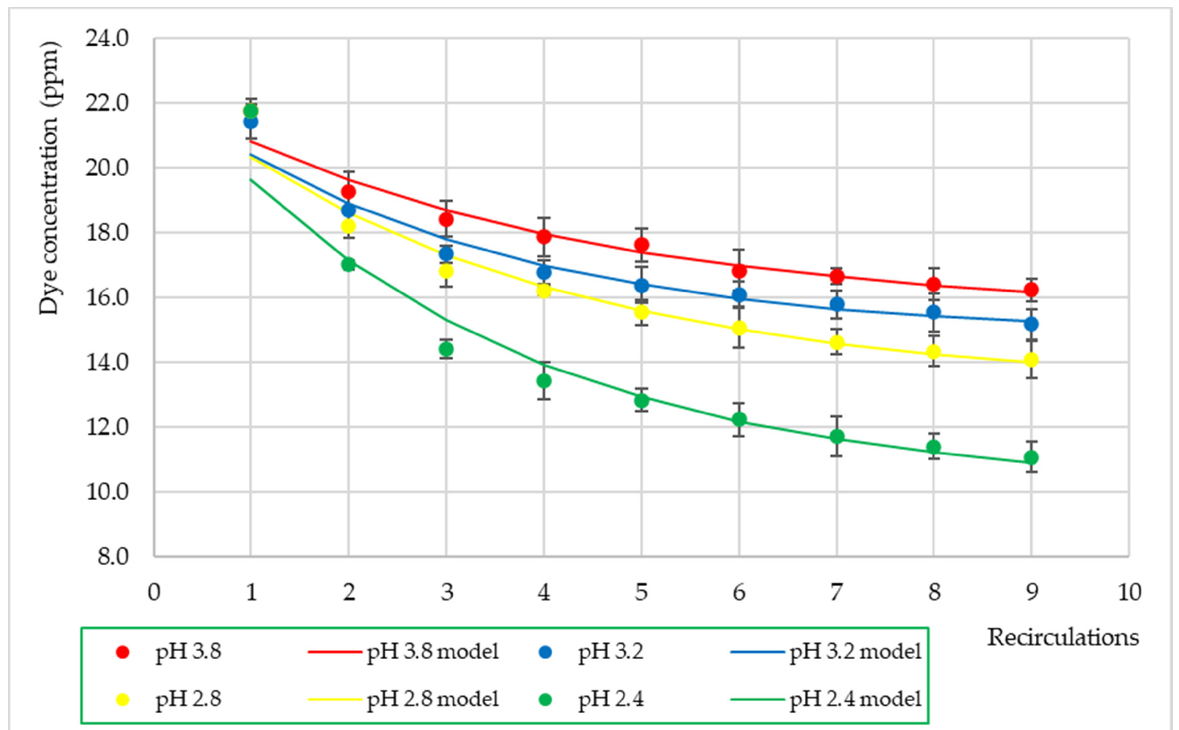
Figure 2. Variation in RB5 concentration (ppm) at different pH values (adjusted with 0.1 M HCl solution). Values adjusted by exponential decay model. Table 2. Parameters of the exponential decay model for RB5 dye removal by original fique fibers using different solution pH